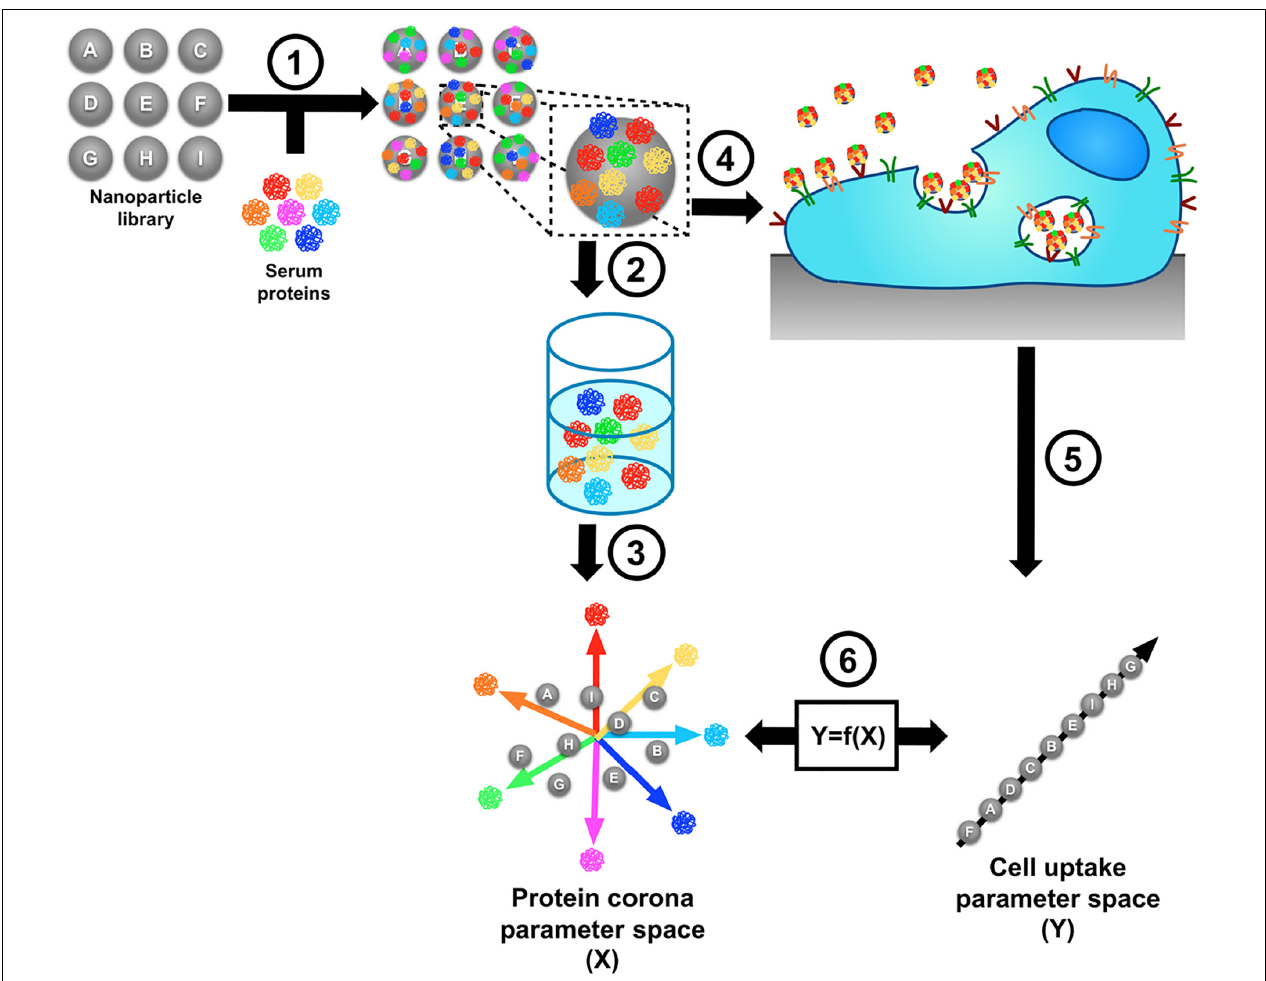
FIGURE 3 | Schematic illustration of the identification of nanoparticle corona proteins that are associated with cellular uptake. (1) A library of different nanoparticle formulations is incubated with a protein mixture in order to form a protein “fingerprint.” (2) The adsorbed proteins are isolated from the surface of the nanoparticles and (3) characterized by mass spectrometry. The serum protein fingerprint is a quantitative representation of each nanoparticle formulation. (4) Nanoparticles are incubated with cells. (5) Net cell association is determined. (6) A function “Y = f(X)” can be used to relate the corona composition to cell association, and f(X) can be used to predict the cell association of a certain nanoparticle formulation from its protein fingerprint. Adapted with permission from Walkey et al. (2014)–Copyright (2014) American Chemical